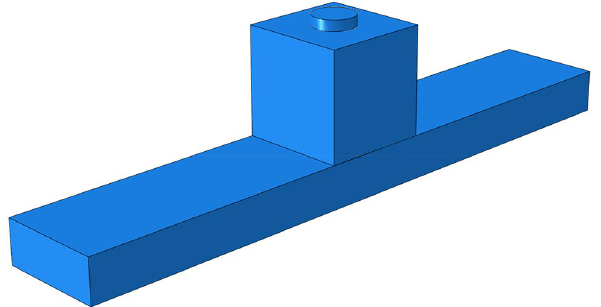
Fig. 1 The FE model created in SIMULIA